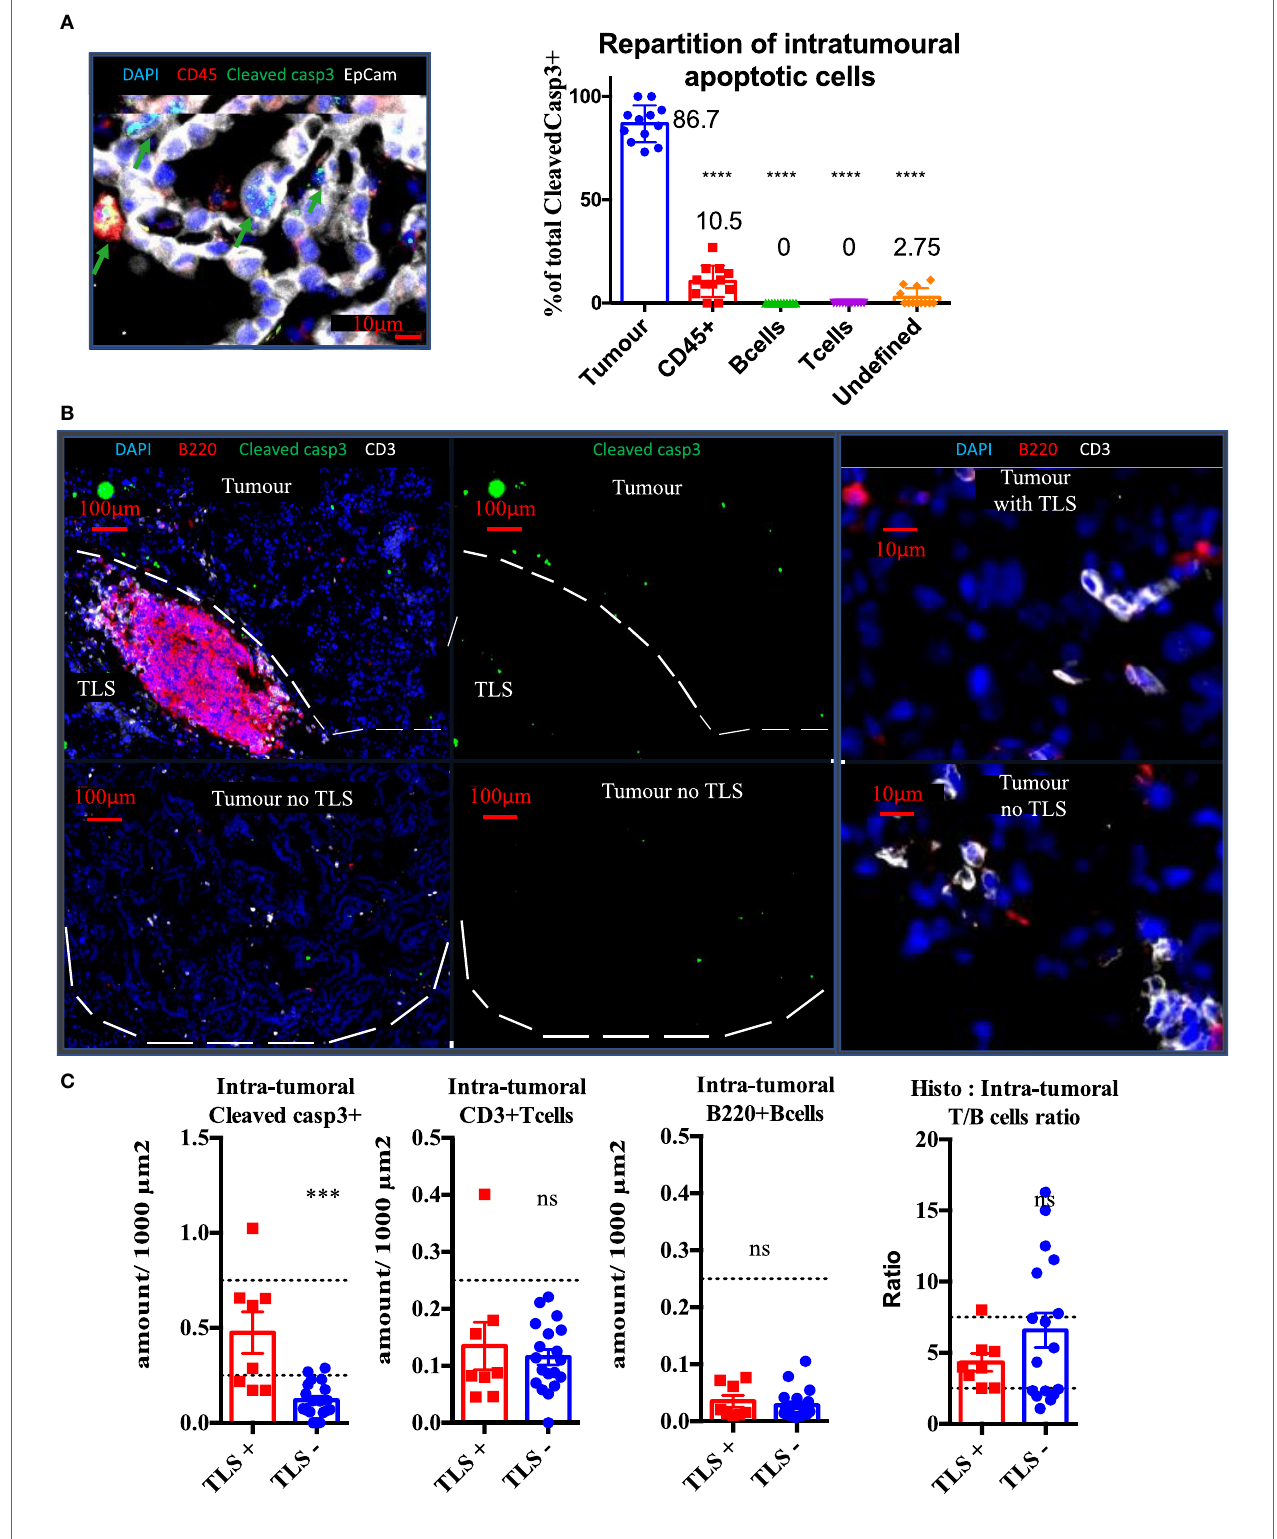
FigUre 3 | Presence of tertiary lymphoid structures (TLS) near tumors is correlated with tumor apoptosis, independently from quantitative B or T cell infiltration. Cleaved Caspase3 co-stainings with CD45 (immune), EpCap (tumor), CD3 (T cells) and B220 (B cells) apoptotic cells are mostly tumour cells (a) . Control tumors with or without TLS were stained to assess wether the immune contexture correlates with apoptosis (White bands delineate tumors) (B) . Quantification per unit surface and T/B cell ratio is shown is (c)